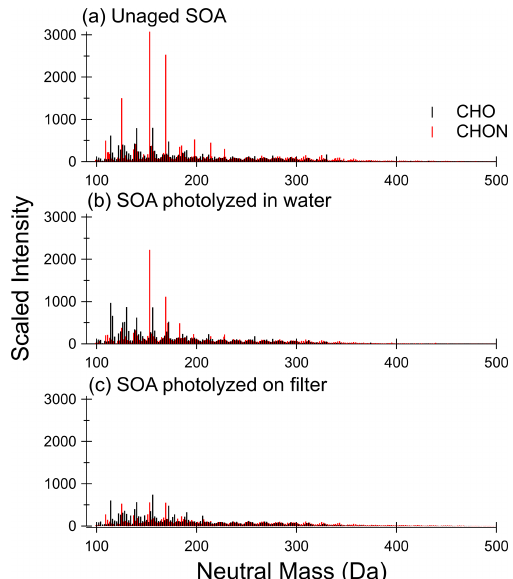
Figure 3. Mass spectra for (a) unaged SOA sample, (b) SOA sam- ple photolyzed 5h in water, and (c) SOA sample photolyzed 5h on the filter from Filter 3. CHON compounds are shown in red, and CHO compounds are shown in black. The signal is scaled to approx- imate pre-photolysis mass concentration of SOA in mass spectrom- etry samples. Control (dark aged) samples are shown in Fig. S8.